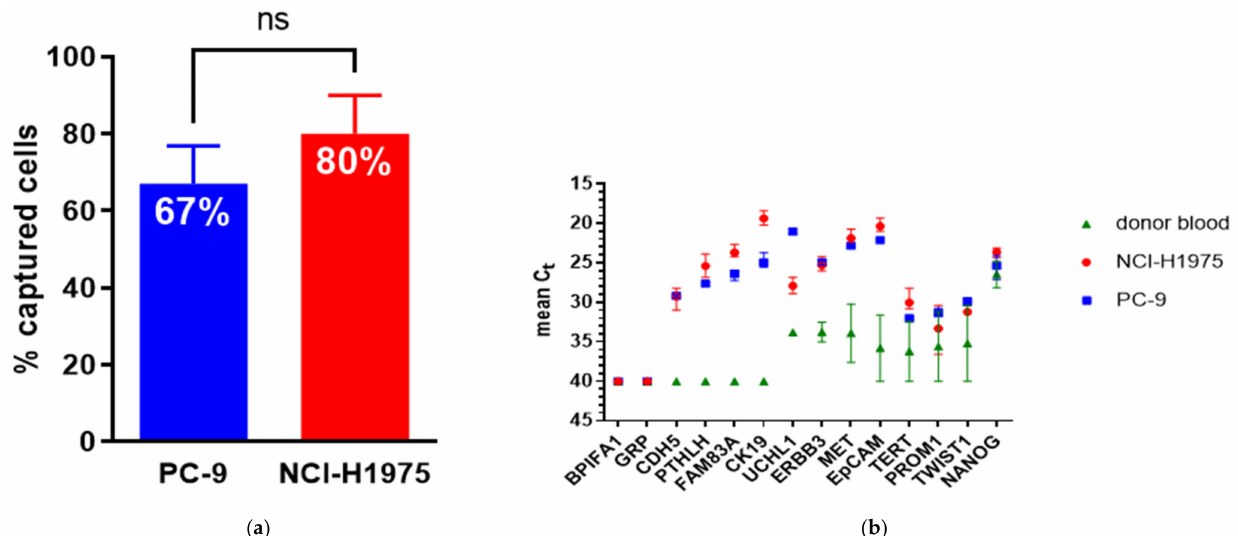
Figure 1. ( a ) Mean rate of PC − 9 and H1975 NSCLC tumor cells captured in the Parsortix™ microfluidic separation cassette with a critical step size of 6.5 µ m. The lines indicate the range of the capture rates observed in duplicate spiking experiments for each cell line (biological replicate); ( b ) the gene expression analysis of the selected gene markers in Parsortix™-enriched blood samples after a target-specific pre-amplification step. The mean Ct values are derived from the two healthy donor blood samples and for each cell line from the two biological and technical replicates. A Ct value of 40 was inserted to visualize undetectable gene expression by qPCR. Lines indicate the range of Ct values within the